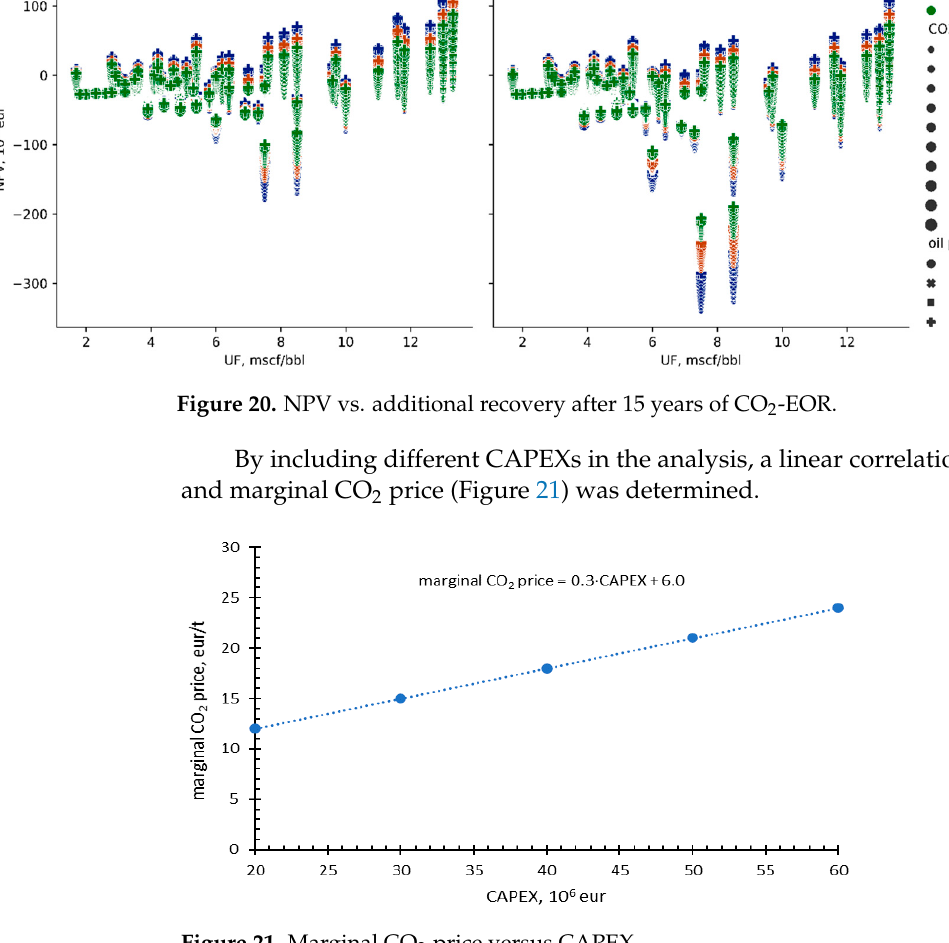
Figure 21. Marginal CO 2 price versus CAPEX.